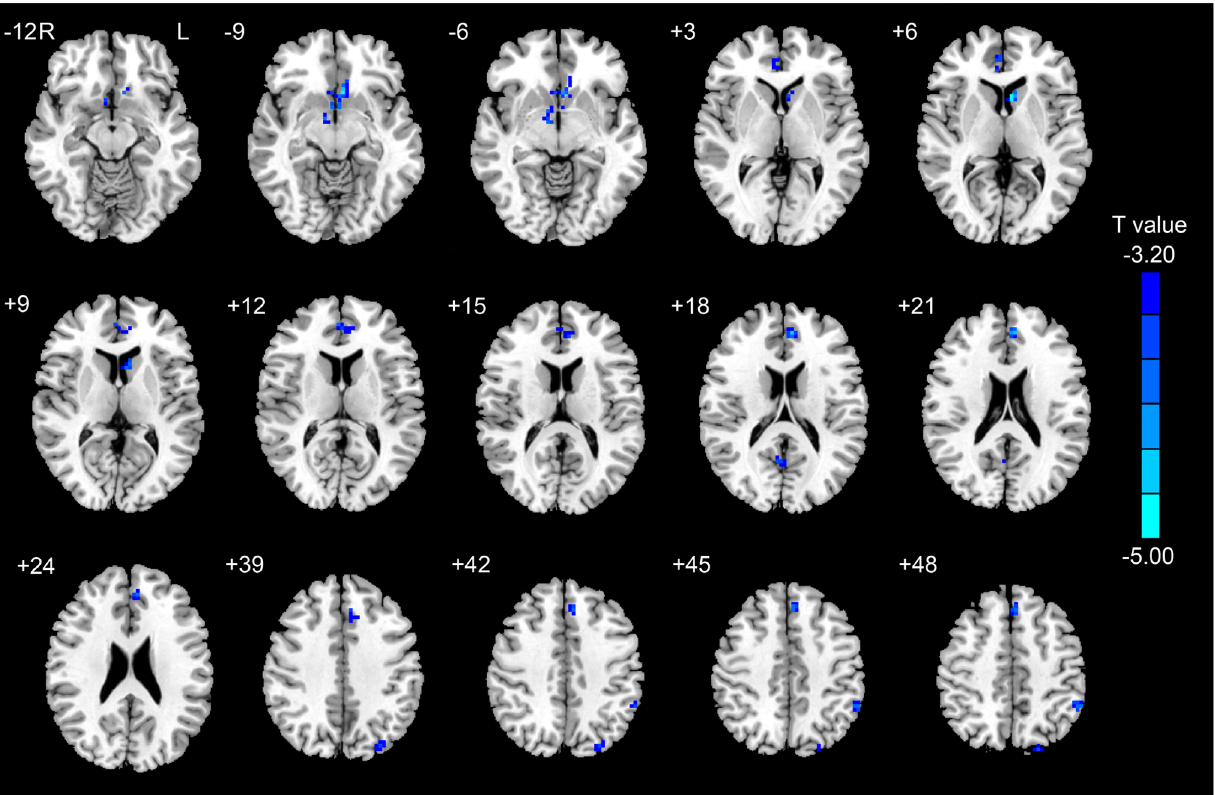
Figure 3. The differences relating to the ‘‘Heroin-Neutral’’ contrast between the LA and SA groups ( P , 0.05, corrected for Monte Carlo simulations).